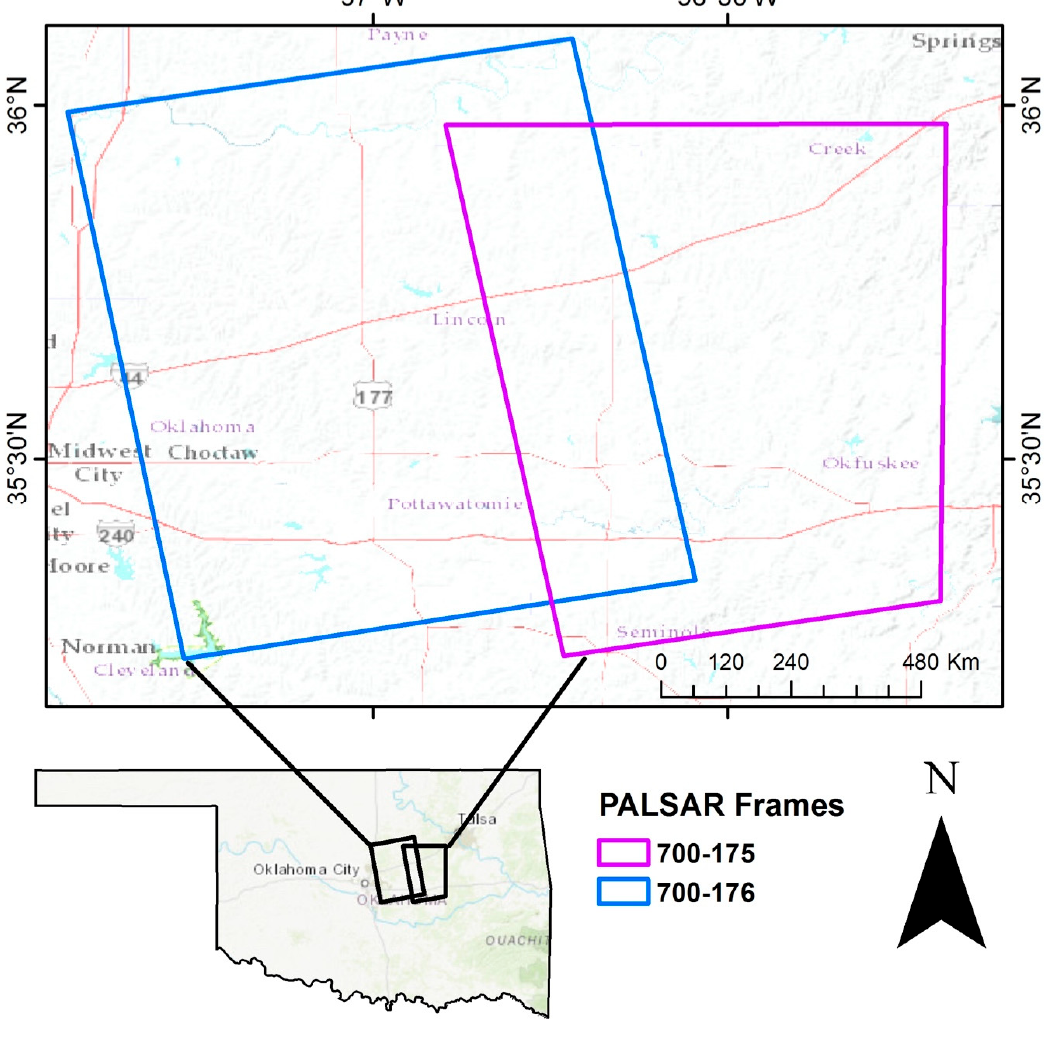
Figure 1. Study Location. Synthetic Aperture Radar Interferometry (InSAR) processed frames shown in blue and purple.